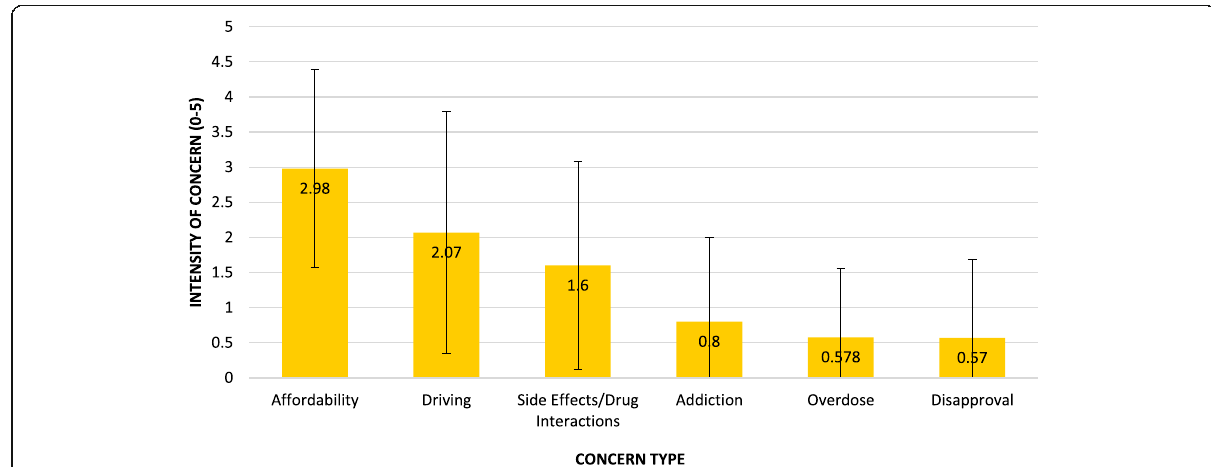
Fig. 7 Responses to questions 19-25: Concerns about medical marijuana among those willing to consider it ( n = 204). Respondents were asked to rate these on a 0-5 point scale (0 = “ not concerned at all ” to 5 = “ wouldn't use MMJ because of this ” ). Columns represent the mean levels of concerns +/ − 1 SD error bars